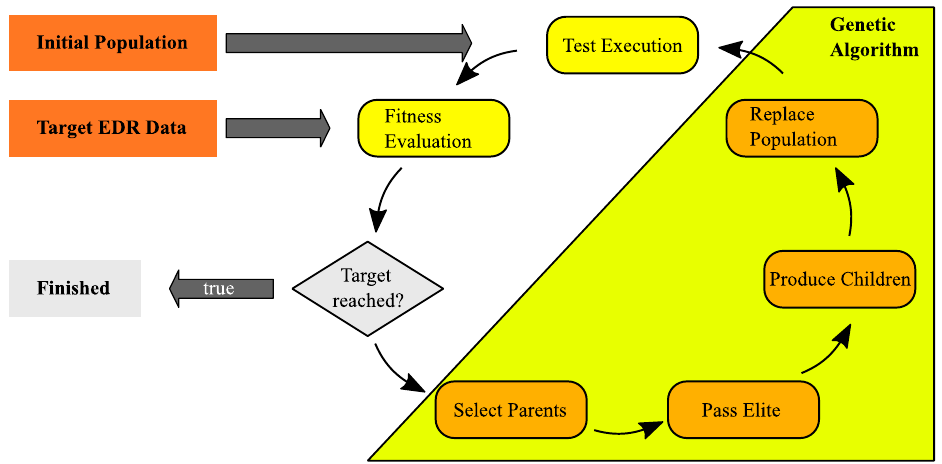
Figure 12. Overview of an automated test execution with genetic algorithms.